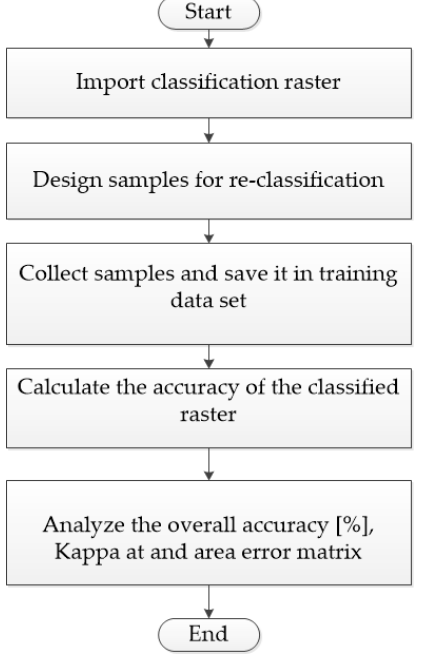
Figure 3. Flow chart representing accuracy assessment of the classified data.